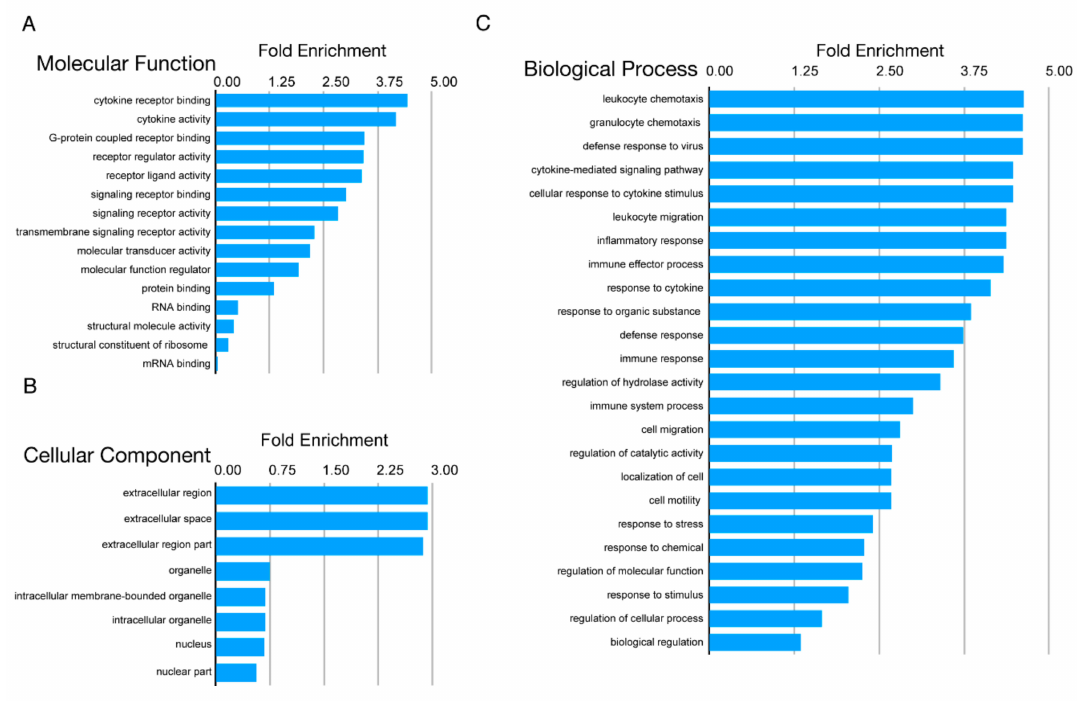
Figure 4. Gene ontology (GO) analysis of most variable genes 24, 48, and 72 h post CVB infection. Figure shows the GO terms for the top 1000 di ff erentially expressed genes identified by RNA-Seq. GO terms are divided into three categories ( A ) molecular function, ( B ) cellular component, and ( C ) biological